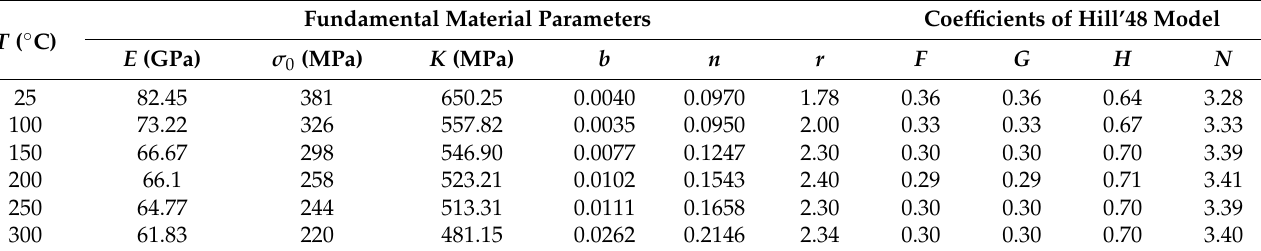
Table 1. Mechanical properties of CP-Ti tube at various temperatures. Fundamental Material Parameters T (°C)